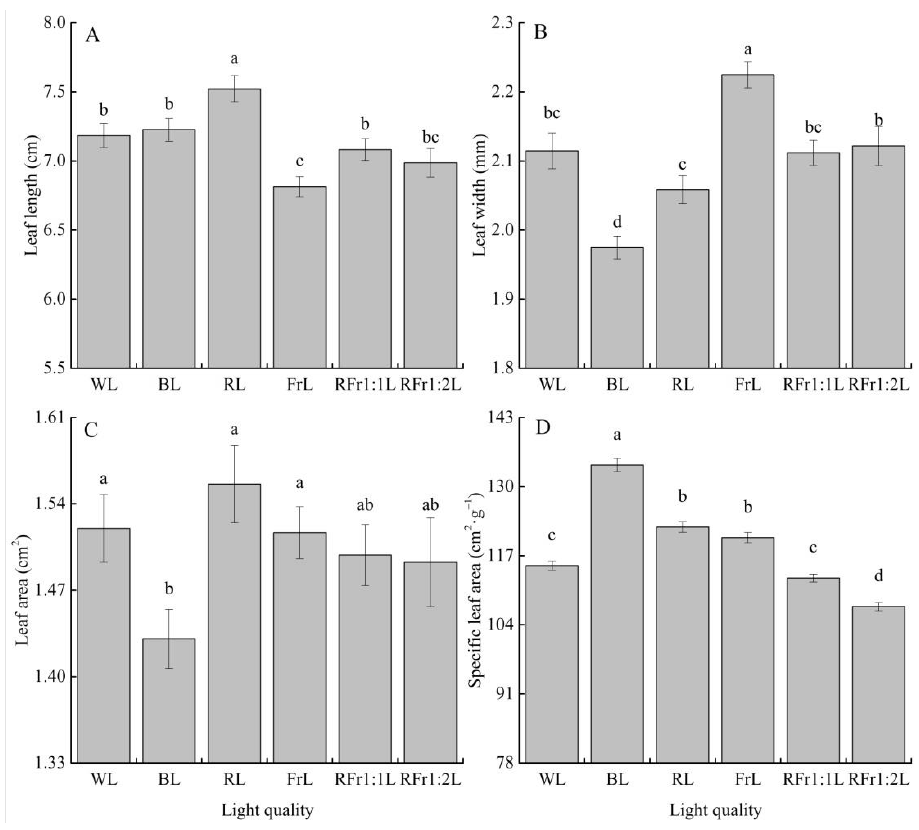
Figure 2. Leaf length ( A ), leaf width ( B ), leaf area ( C ), and specific leaf area ( D ) of Cunninghamia